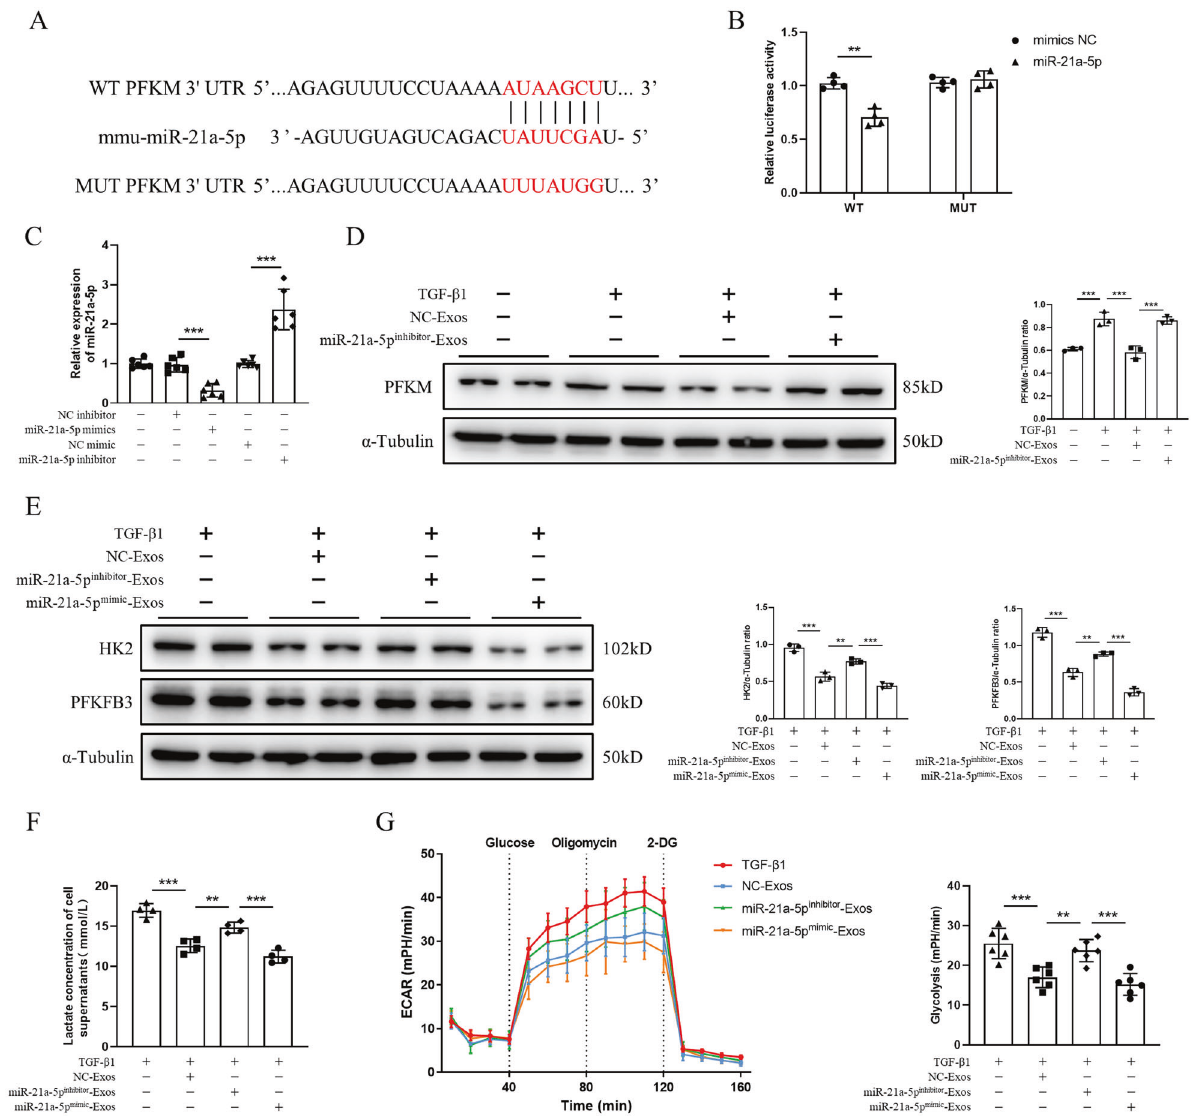
transfection ( n = 4). C Relative expression of miR-21a-5p in MSCs transfected with miR-21a-5p inhibitor, NC inhibitor, miR-21a-5p mimic, or NC mimic by qPCR ( n = 6). D The expression of PFKM was assessed by western blot analysis in PBS-, TGF- β 1-, NC-Exo- and miR-21a-5p inhibitor -Exo- treated TCMK-1 cells ( n = 3). E The expression of HK2 and PFKFB3 in TCMK-1 cells was assessed by western blot analysis ( n = 3). F Lactate concentration in the supernatant of TCMK-1 cells ( n = 4). G ECAR of TGF- β 1-, NC-Exo-, miR-21a-5p inhibitor -Exo- and miR-21a-5p mimic -Exo-treated TCMK-1 cells ( n = 6). Data are presented as the mean ± SD from three independent experiments. ** p < 0.01 and *** p <